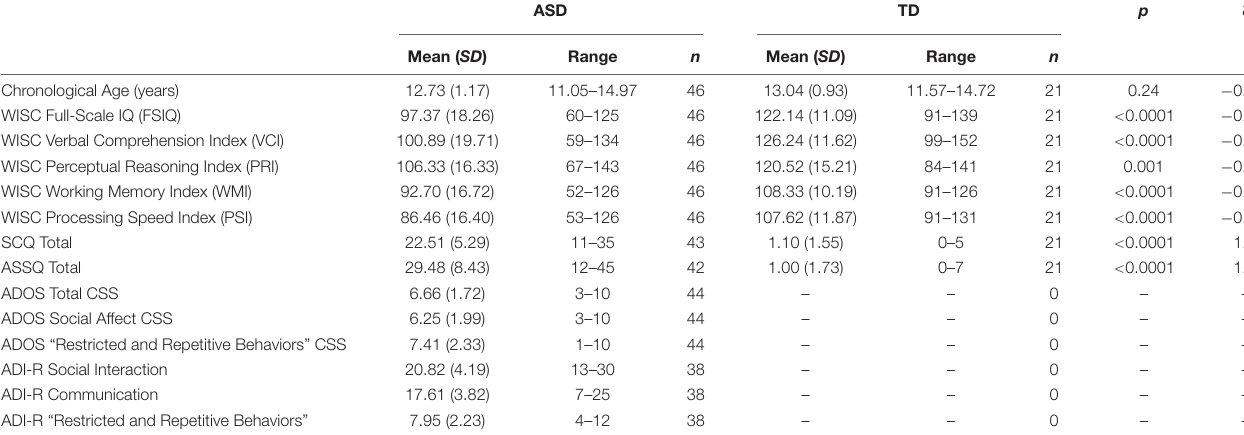
TABLE 1 | Characteristics of autistic and typically-developing